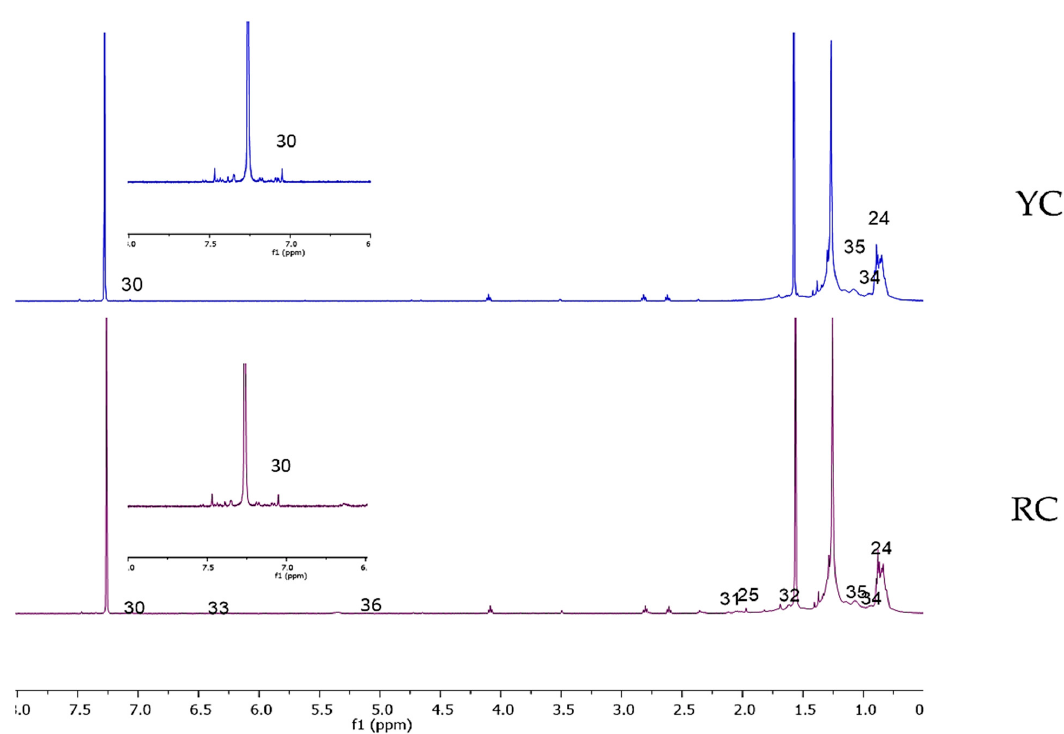
Figure 2. Representative 1 H-NMR spectra of red watermelon (RC) and yellow watermelon (YC) in